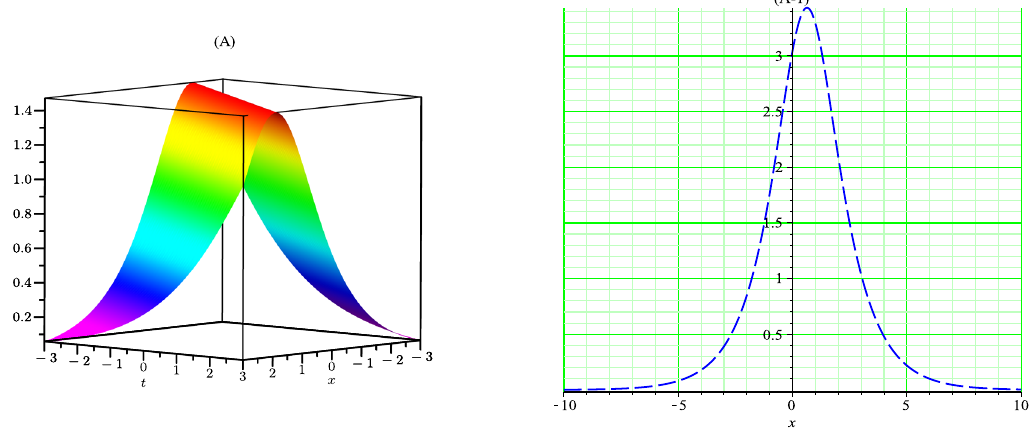
Figure 1: ( A ) 3D graph of ( 20 ) with a 1.75 =